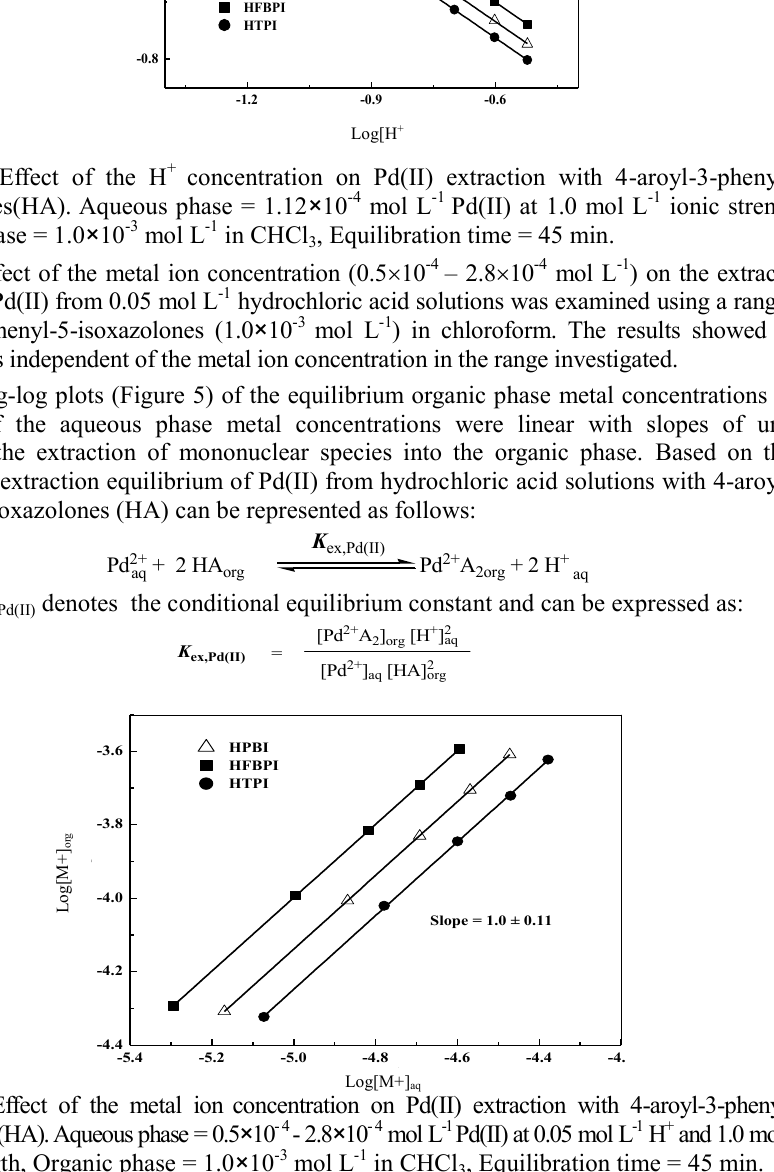
, Equilibration time = 45 3